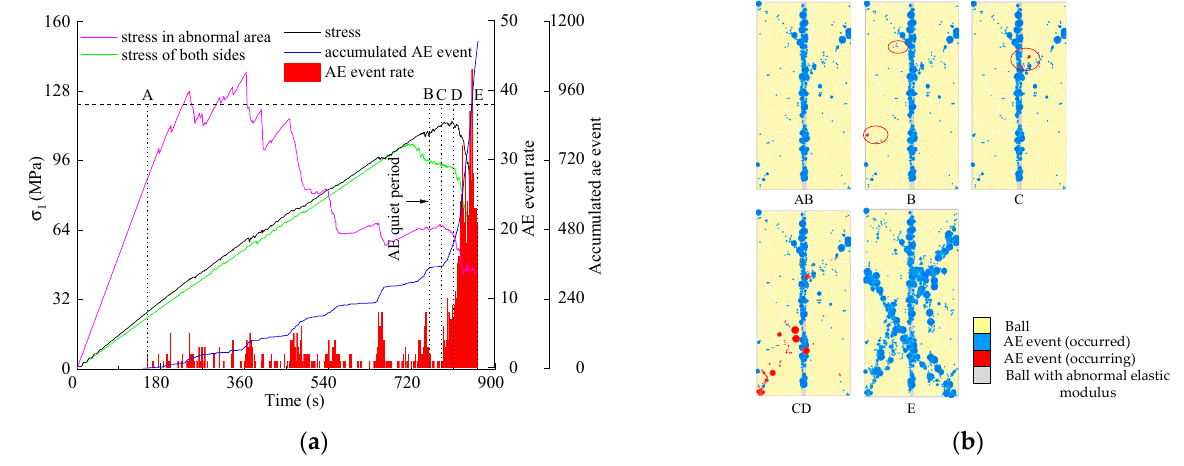
( b ) Figure 8. Numerical simulation results. ( a ) Stress and AE events of specimens with abnormal elastic modulus of 100 GPa; ( b )AE events distribution at different stages of the specimen.